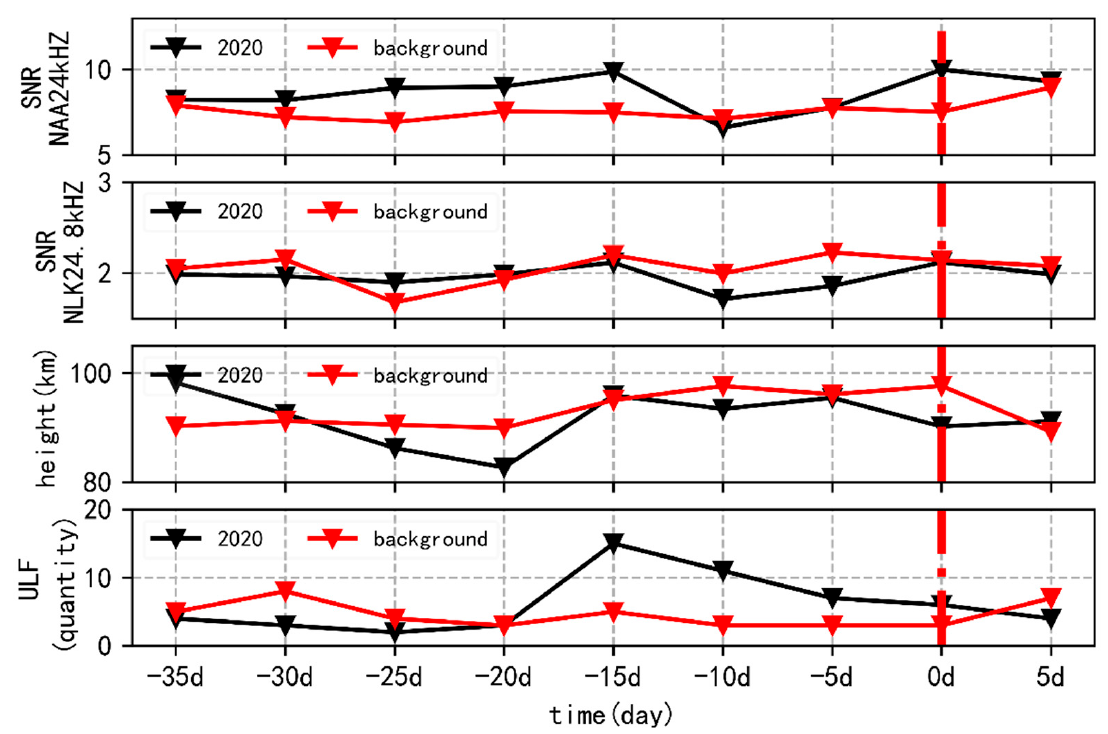
Figure 11. The statistical diagram of the changes in the various parameters of the electric field in the seismogenic zone before and after the earthquake.